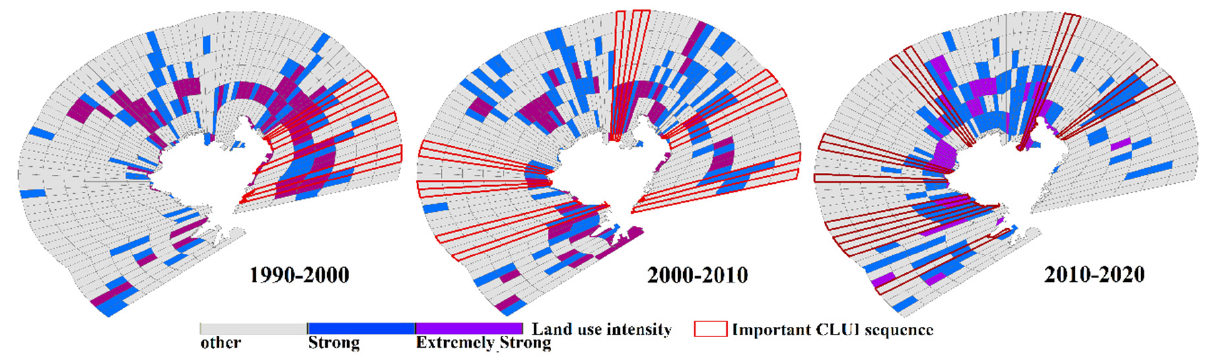
Figure 6. Distribution of the important CLDI sequences in the Qingdao coastline zone. From 2000 to 2010, the function of berthing freighters was mainly transferred from Qingdao Port to Qianwan Port, and the industrial sector moved from the east bank to the west bank. The westward migration of the freight center spurred industrial structure ad- justment and enhanced port-vicinity industry agglomeration. Several strong and ex- tremely strong CLDI units have accumulated in the Qianwan port area. The typical sea– land CLDI sequence on the western coast exhibited the pattern of Extremely Strong Change Coastline -> Strong > Medium > Weak, and the LDI decreased from sea to land (Figure 6). The speed of coastline development in the Qingdao Port area was slow, so the strong LDI units were mainly located in the middle of the sequences. The most prominent LUT sequence pattern of the western coast port area was Wa → BL > CL → BL > FL → CL > CL → BL > CL → GP, and the growth rate of BL was the fastest. The sequences located on the eastern coast were represented by the pattern CL → BL > GP → BL > CL → BL > CL → GP. At the end of the sequence, large areas of CL and GP were transferred into BL in the interior. In 2010–2020, Qingdao undertook industrial transfer by building six industrial zones—namely, Yanghe Equipment Manufacturing Industry Base, Dongjiakou Chemical Industrial Park, Jimo Automotive Parts Industrial Park, Xinhe Chemical Industrial, Jiang- shan Light Industrial Park and Nvdao Shipbuilding Industry Base [38]. Strong change areas were mostly distributed in Laidong, Jiaozhou, Pingdu and other places close to the coastline, forming Weak Change Coastline -> Weak > Strong > Medium and AS → OL > AS → BL > CL → BL > GP → CL sequence patterns (Figure 6). The mode of port-driven urban construction was replaced by the mode of surrounding industrial renewal, and the land development along the port shoreline weakened and presented a Weak Change Coastline -> Weak > Medium > Weak sequence pattern. Under the export-oriented devel- opment strategy emphasizing airport and seaport traffic, the Jiaodong airport and its sup- porting facilities, such as the Eurasian economic and trade cooperation industrial park, were constructed, and this series of projects promoted the transfer of the areas surround- ing GP and CL into BL. As a result, the Northwestern Jiaozhou Bay region and Jiaozhou suburbs, as the core of the new zone, radiated to the surroundings and formed AS → BL > CL → BL > AS → BL > CL → BL and AS → BL > AS → CL > CL → BL LUT se- quence patterns.